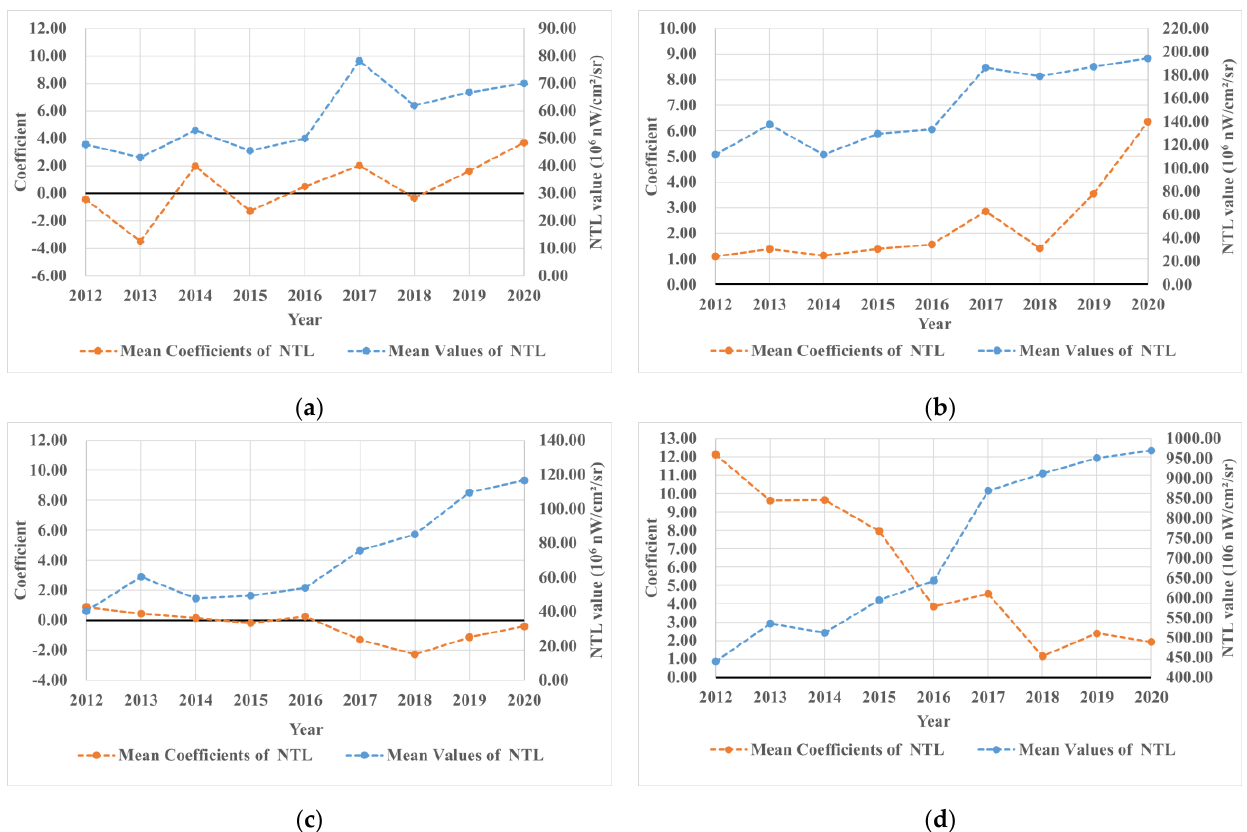
Figure 8. Temporal trends of mean NTL values and mean NTL coefficients in ( a ) Huangshan; ( b ) Xuancheng; ( c ) Anqing; ( d ) Hefei.